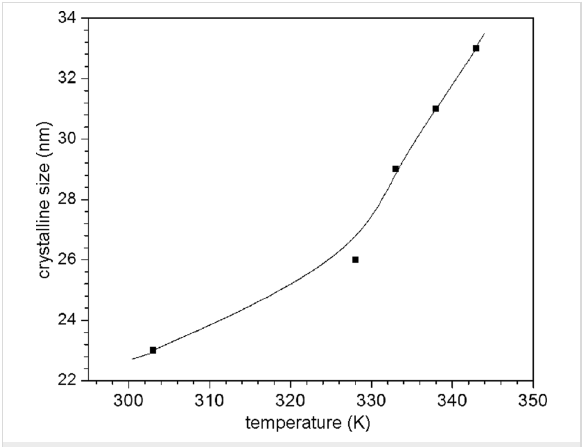
Figure 2: Variation of the average crystallite size of PbSe thin films with the deposition temperature.